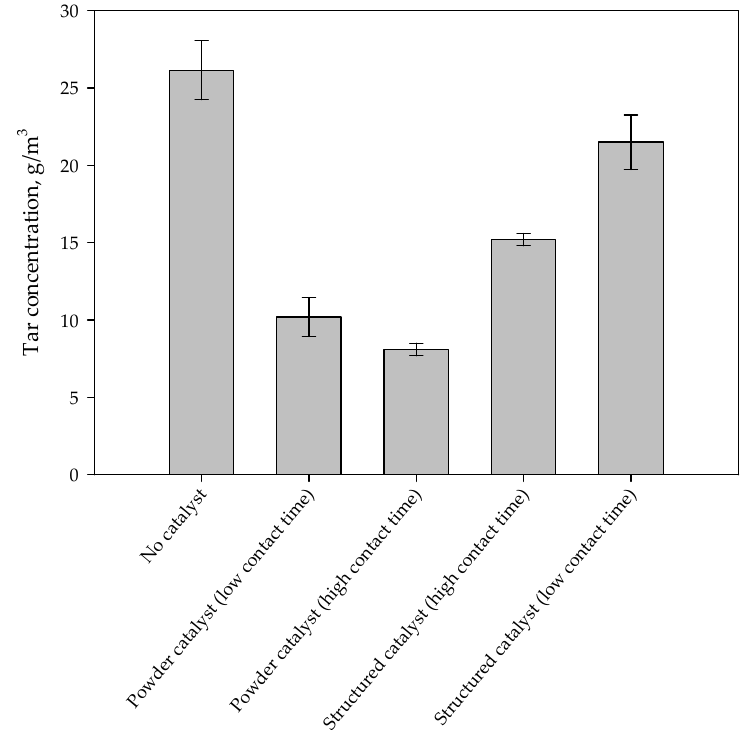
Figure 3. Tar concentration in the synthesis gas during standard and enhanced gasification tests.